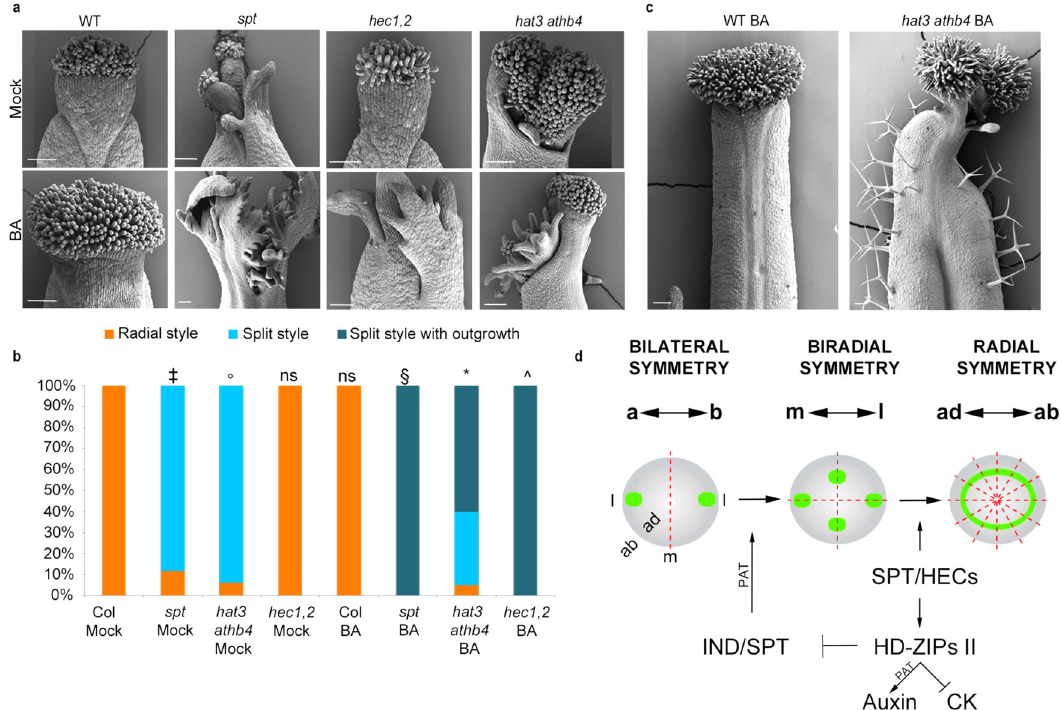
Fig. 4 HAT3 and ATHB4 suppress sensitivity to cytokinin. a SEM images of stage-13 gynoecia of Col-0 wild-type, spt single mutant, hec1,2 and hat3 athb4 double mutants treated with mock (top) or 50 µ M of cytokinin (BA) (bottom). Scale bars represent 100 µ m. b Quanti fi cation of cytokinin (BA) effect on gynoecium apex development of genotypes depicted on the graph. Phenotypic classes were compared using 3 × 2 contingency tables followed by Pearson ’ s χ 2 test. Two-tailed P values are as follows: spt-12 Mock vs Col Mock, P < 0.00001 ( ‡ ); hat3 athb4 Mock vs Col Mock P < 0.00001 (°); hec1,2 Mock vs Col Mock P = 1 (ns, no statistically signi fi cant difference); Col BA vs Col mock, P = 1 (ns); spt-12 BA vs spt-12 mock, P < 0.00001 (§); hat3 athb4 BA vs hat3 athb4 mock, P < 0.00001 (*); hec1,2 BA vs hec1,2 mock, P < 0.00001 (^). P values < 0.01 were considered as extremely statistically signi fi cant. c SEM images of stage-13 gynoecia of wild-type (left) and hat3 athb4 (right) treated with 50 µ M of BA, showing the occasional trichome formation on the valves of the hypersensitive double mutant. Scale bars represent 100 μ m. Similar results were obtained from two independent experiments. d Model showing the genetic regulation of consecutive transitions of auxin signalling (green) at the gynoecium apex (grey outline — top view). Double-head arrows represent the polarity axis; a apical domain, b basal domain, m medial domain, l lateral domain, ab abaxial domain, ad adaxial domain. Dashed red lines represent the planes of symmetry along the medio-lateral axis. PAT polar auxin transport, CK